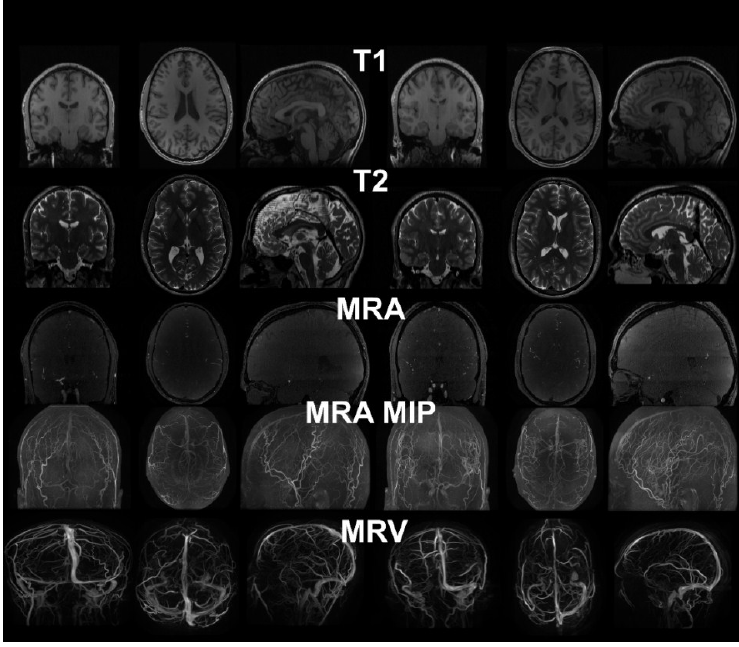
Figure 2. MRI images from two healthy subjects. T1 provides distinction of grey and white matter, skull and scalp. T2 provides cerebrospinal fluid space and contrast between gray and white matter. MRA enhances the intensity of vessels using flow phenomenon. The maximum intensity projection (MIP) provides better distinction of vasculature compared to the raw image. Due to the pulse sequence design, the brain tissue was removed from the MRV, showing only the signals from the